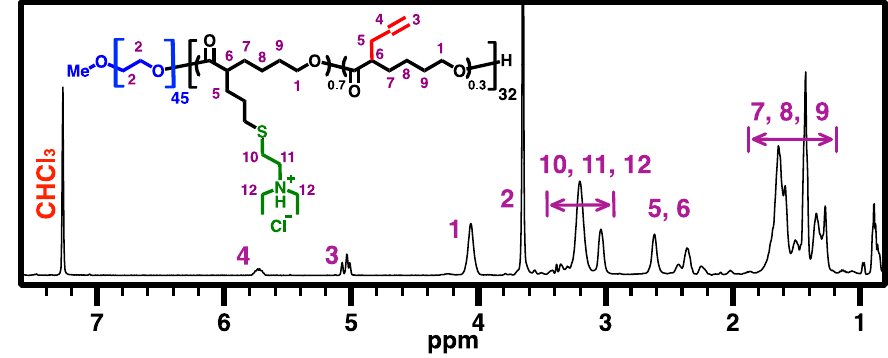
Figure 4. 500 MHz 1 H NMR spectrum of PEG- b -CPCL-70 ( 3 ) in CDCl 3 .